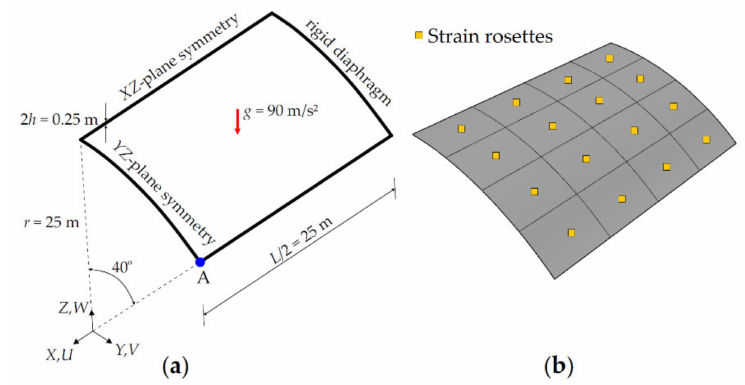
Figure 5. ( a ) Scordelis–Lo roof with symmetric boundary conditions; ( b ) its discretization (n e = 4), using iKLS elements with top- and bottom-surface strain rosettes per each